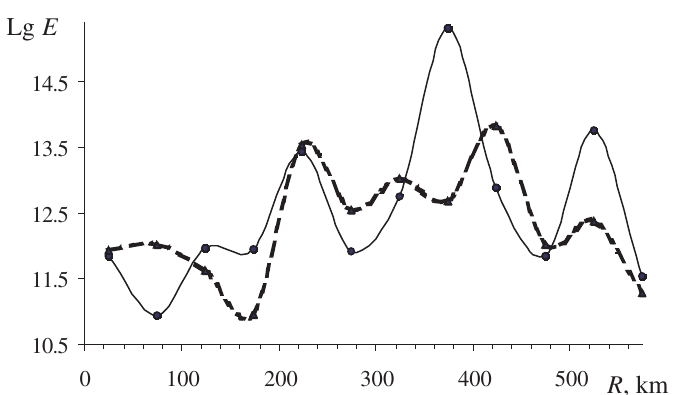
Fig. 4. The total seismic energy of earthquakes of the North Tien Shan and adjacent areas occurring before E b (dashed line) and after E a (solid line) 114 MHD-generator start-ups as a function of the distance to location of the MHD-generator on Bishkek test-site. The values E a and E b are plotted on a logarithmic